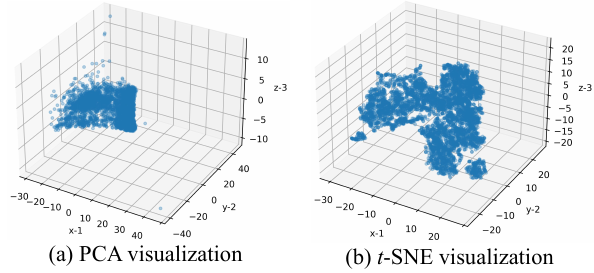
Figure 2 . Comparison of PCA and t -SNE for feature dimensionality reduction of the Indian Pines-A (IA) data set.